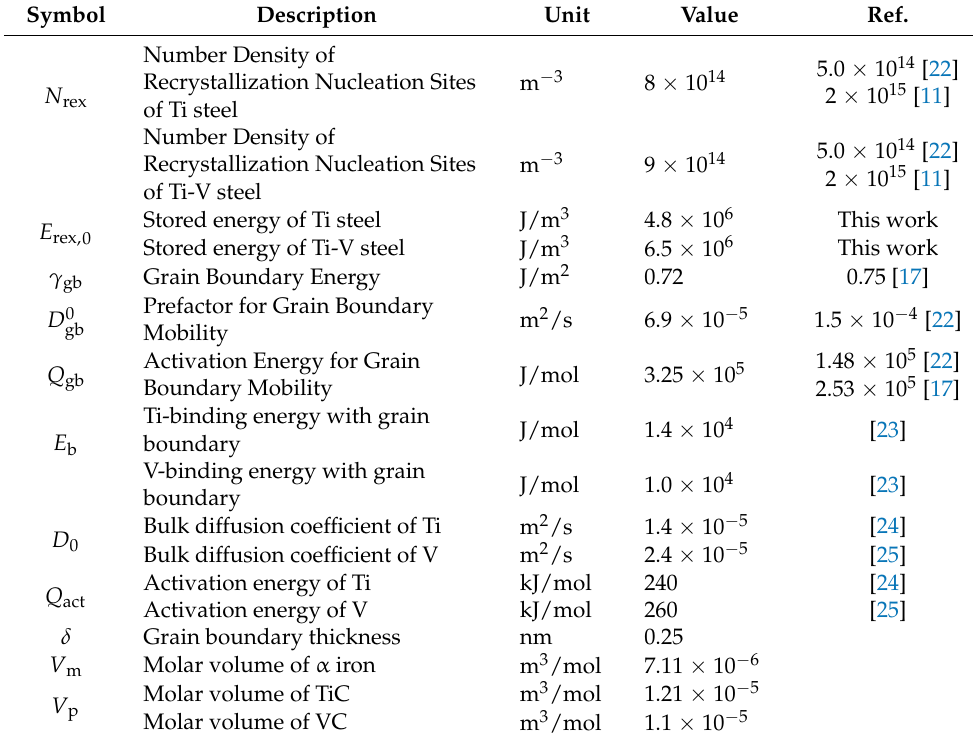
Table 2. Values of the key parameters used in the recrystallization model.